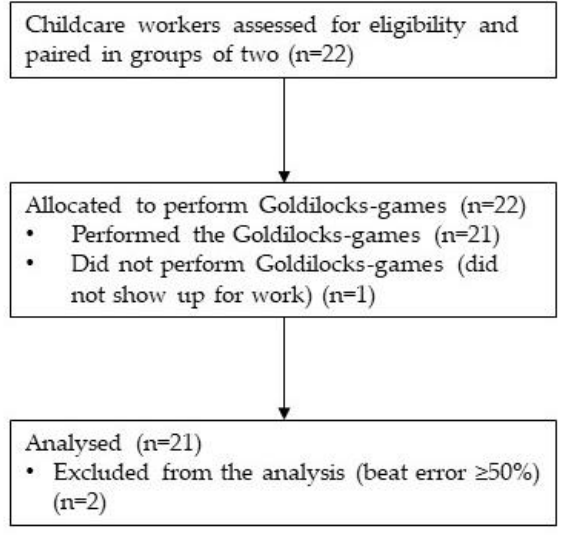
Figure 4. Participant flow, leading to the final sample of 19 workers.